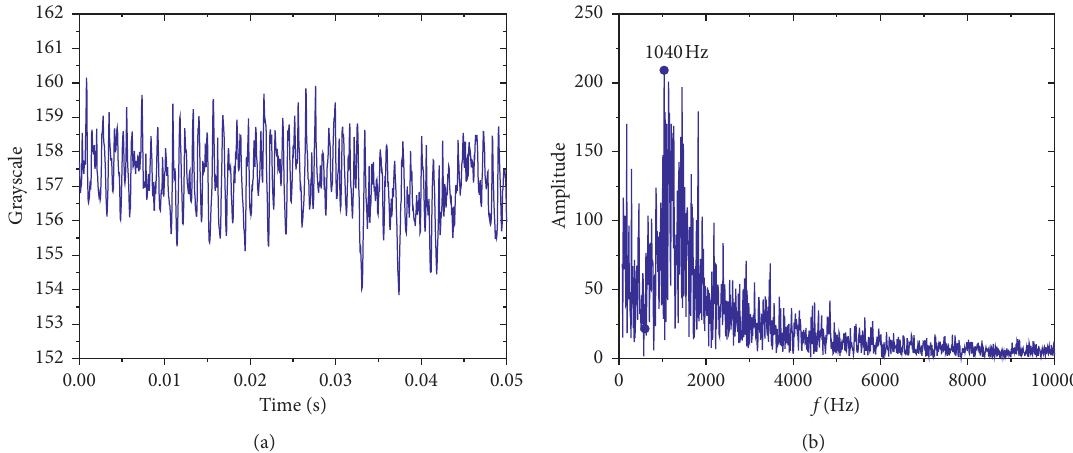
Figure 10: Global averaged grayscale value. (a) Time domain. (b) Frequency domain.